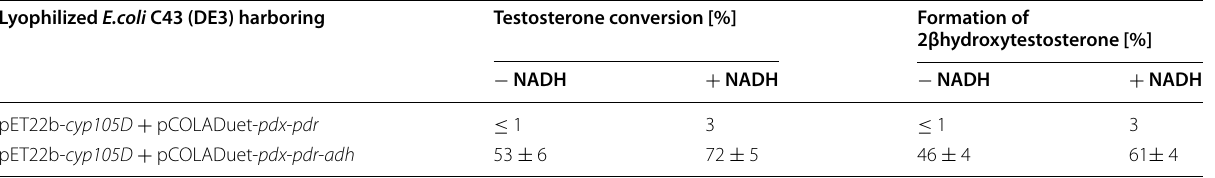
Table 1 Effect of external NADH addition on the activity of lyophilized P450 whole-cell